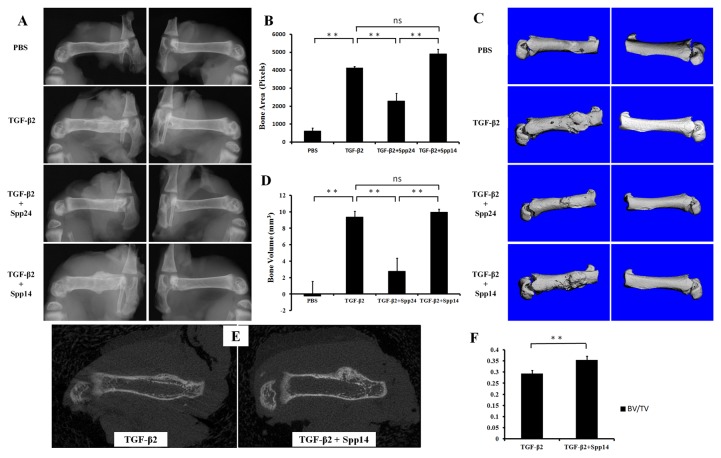
Radiographs of femurs of newborn rats treated for 14 consecutive days with TGF-β2 alone or with Spp24 or with Spp14.5.Representatives of treatment groups as follows: A.X-ray images, with both various treated left femurs and untreated right femurs; B. Bone area derived from radiographic analysis of femurs of newborn rats with different treatment (**: P<0.01); C. CT images of treated femurs and untreated control; D. Bone volume of newly formed bone derived from CT images (**: P<0.01); E. 2D CT image comparing new bone quality of TGF-β2 group and TGF-β2 + Spp14.5 group; F. BV/TV value from the new bone formation area of TGF-β2 group and TGF-β2 + Spp14.5 group.